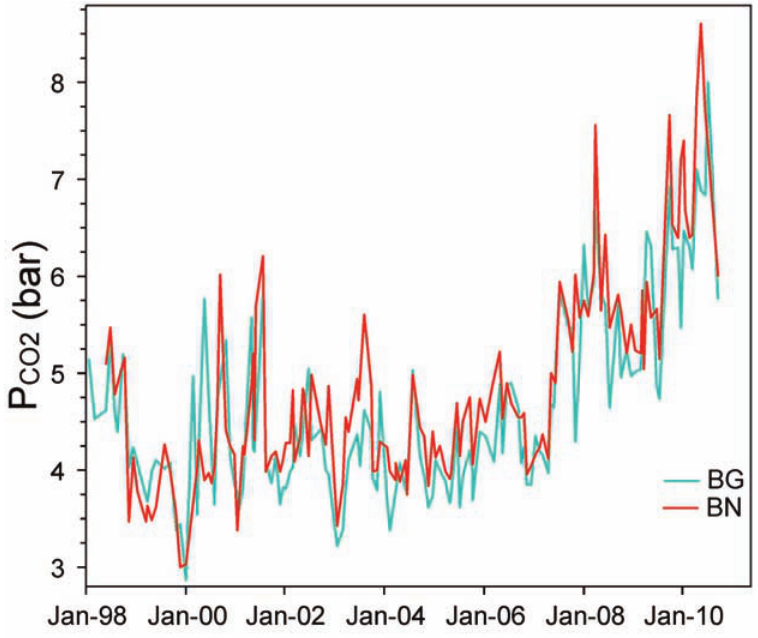
Figure 10. Chronogram of the P estimated at the BG and BN fumaroles. Since 2007, an increase in the values has been observed, and this pressurization CO2 process is still